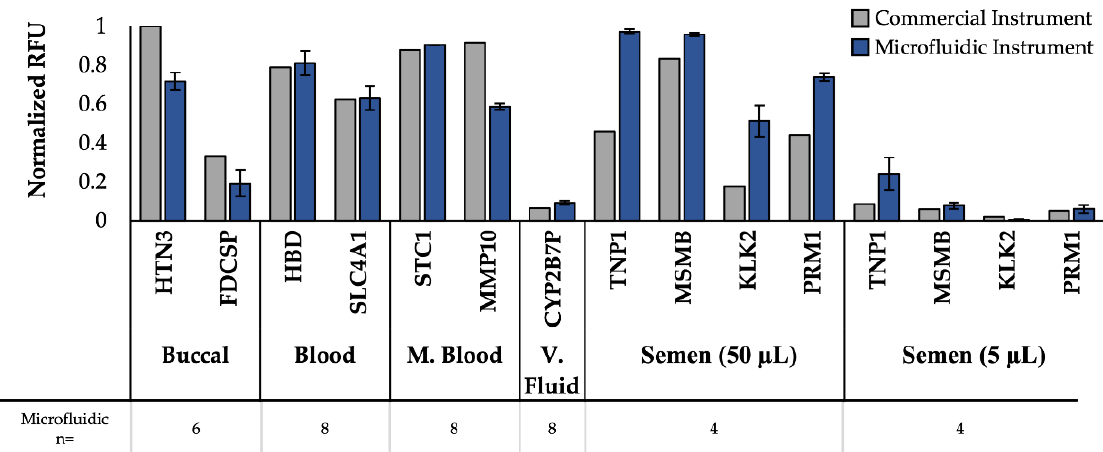
Figure 4. Single source fluid comparison of normalized peak heights from a commercial CE instru- ment and the microfluidic system.